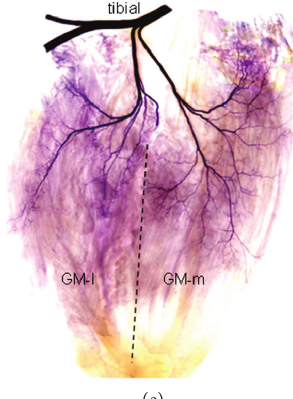
Figure 2: A Sihler’s stained rat hind limb, showing the major branches of the sciatic nerve and their distribution in the calf muscles. (a) Low- power view of the Sihler’s stained left hind limb after microdissection, 4x. The sciatic nerve is divided into three major branches: CP, tibial, and sural (sensory). The peroneal nerve gives off branches to innervate TA and EDL. The tibial nerve gives off branches to supply the GM, soleus, FHL, FDL, and muscles in the foot. The GM-l and GM-m are outlined by white dotted lines. (b) Magnification of the boxed region in A showing the intramuscular branching and distribution patterns of the peroneal and tibial nerves. The upper part of the tibia was removed. The deep peroneal nerve (DPN) supplies branches to the TA and EDL. The tibial nerve gives off three branches, first branch to the GM, second branch to the foot, and third branch to the FHL and FDL. Also, the GM nerve branch gives off two secondary branches, one innervating the GM-l and soleus and another supplying the GM-m. SPN, superficial peroneal nerve, 12x. (c–e) High-power view of the branching of the sciatic nerve and intramuscular innervation of the tibial and peroneal nerves,